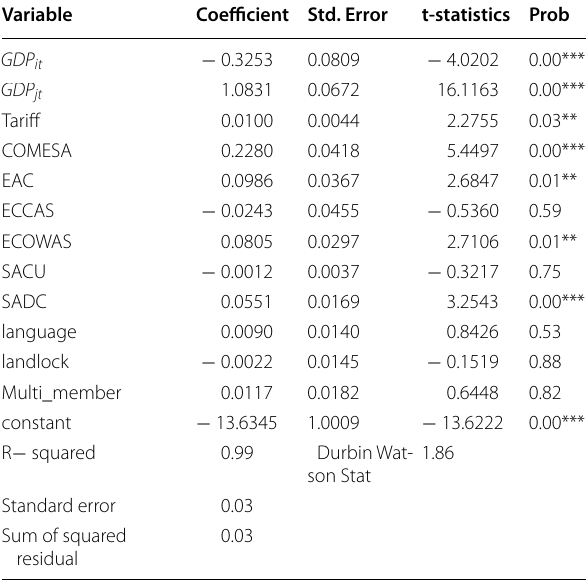
***,and ** indicate 1% and 5% significance level